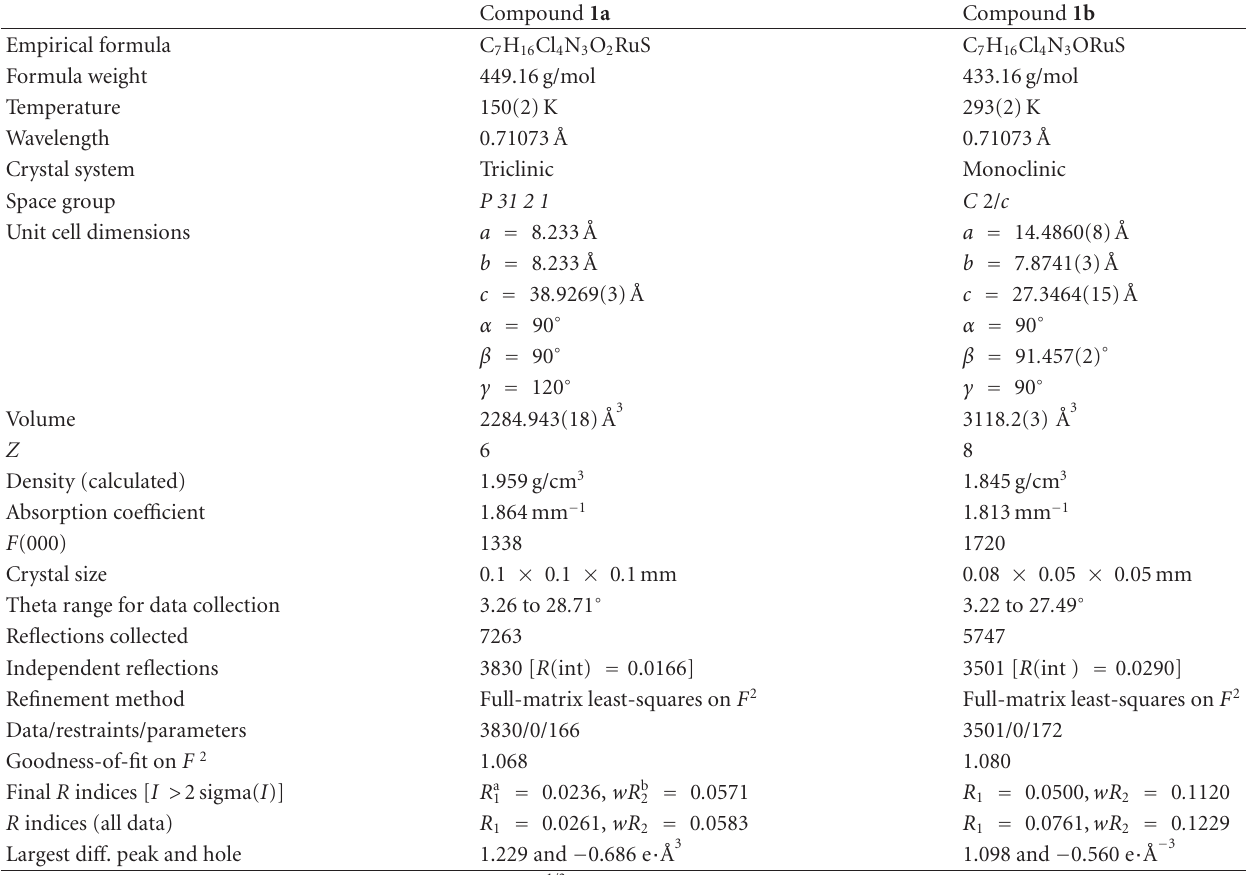
Figure 3: The packing in the crystal structure of compound 1a along the z axis. Table 1: Crystal data and structure refinement for compounds 1a and 1b